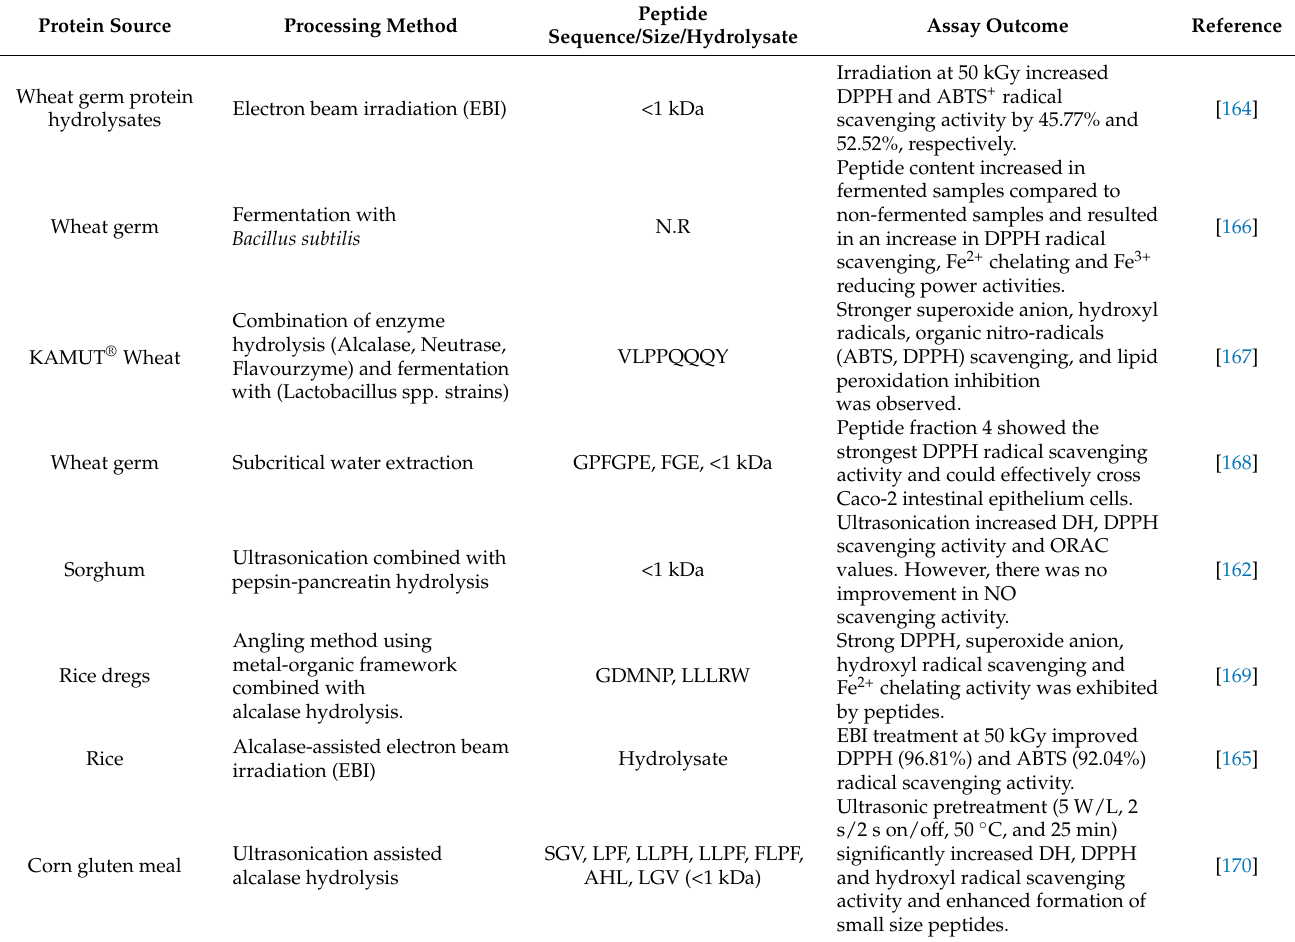
Table 5. Cereal antioxidant peptides using different processing